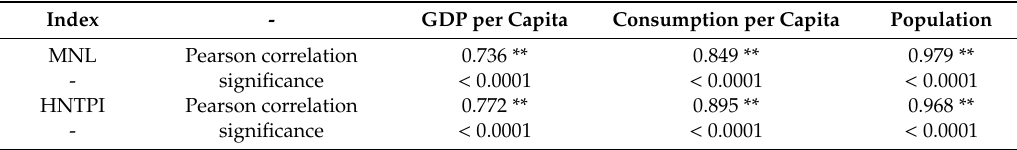
Table 5. Correlation between MNL, HNTPI, and social-economic parameters.